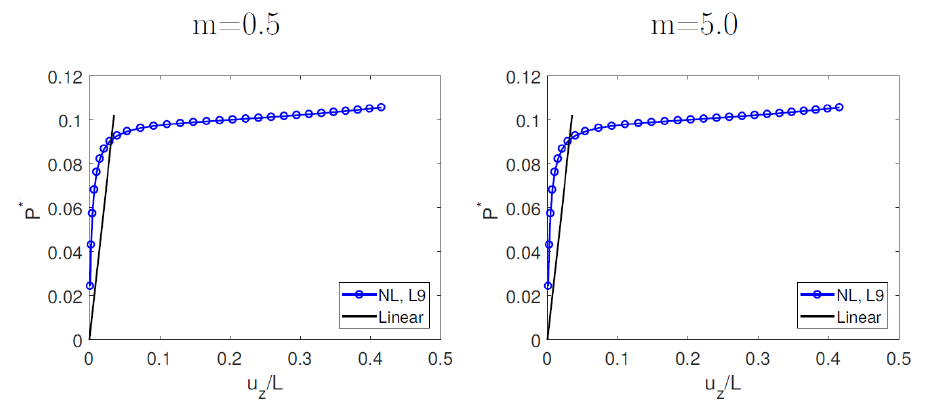
Figure 21. The equilibrium curves for L9 of two-cell FG beam subjected to axial loading, P ∗ = 4 PL 2 / π 2 EI .